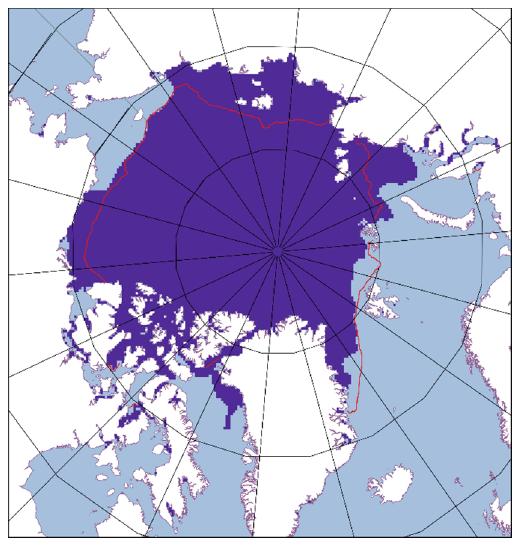
Figure 9. September minimum sea ice extent for 1996 and the climatological 1981–2010 mean (red contour). Data obtained from National Snow and Ice Data Center (NSIDC).